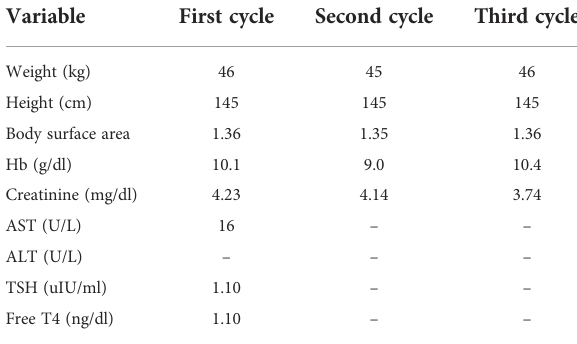
TABLE 1 Clinical characteristics of case 1. TABLE 2 Clinical characteristics of case